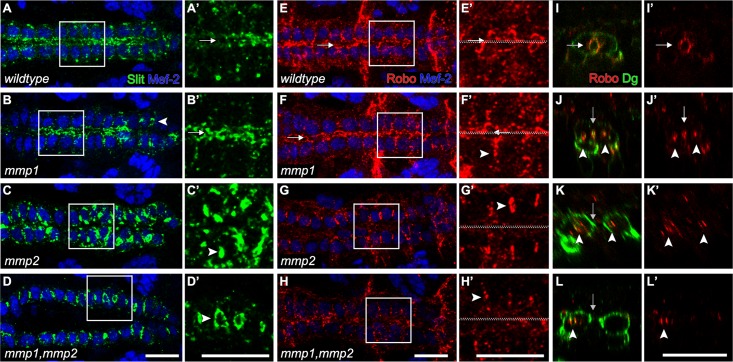
Slit and Robo localise to ectopic lumens in mmp mutants.(A-H) Wildtype and mmp mutant embryos labelled with α -Slit and α -Robo. (I-L) Cross-sectional view of wildtype and mmp mutant embryos labelled with α-Dg and α-Robo. (A) In wildtype, Slit localises to the luminal domain of the stage 17 CBs (arrow). (B) In mmp1 mutants, Slit localises to the luminal domains (arrow), however lateral mislocalisation is also observed (arrowhead). (C,D) In mmp2 and mmp1,mmp2 mutants, Slit is mislocalised, accumulating ectopically at the lateral domains of the CBs (arrowheads). (E, I-I’) In wildtype, Robo localises to the luminal domain (arrows). (F,J-J’) In mmp1 mutants, apical (arrow) and lateral (arrowhead) distribution of Robo is observed. In mmp2 (G,K-K’) and mmp1,mmp2 (H,L-L’) mutants, Robo localises to the lateral domains of CBs (arrowhead), whereas Dg is distributed throughout the plasma membrane (arrow). Scale—10 μm.